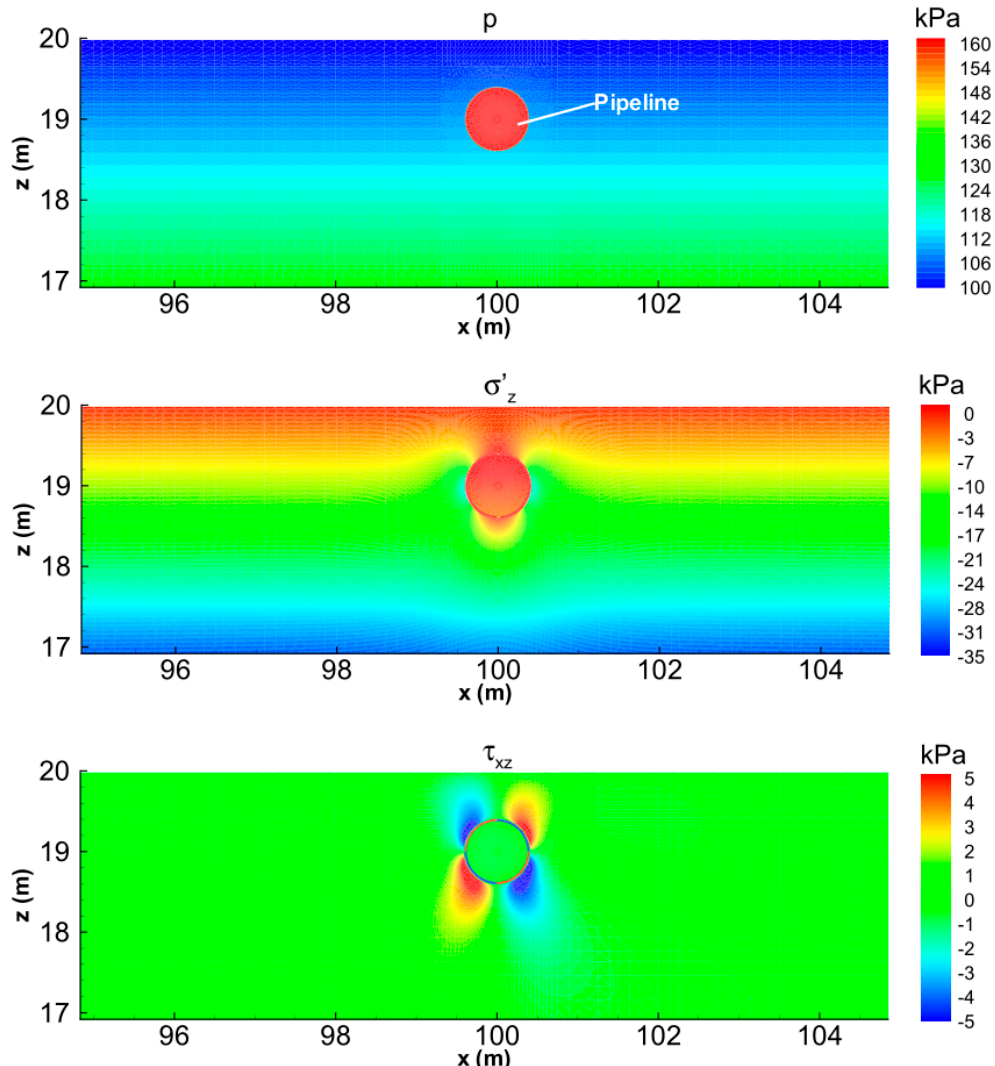
Figure 5. E ff ective stress and pore pressure distribution of the pipeline-seabed in consolidated status. The distribution of the vertical e ff ective stress σ z ’ indicates that an upward buoyancy is applied on the